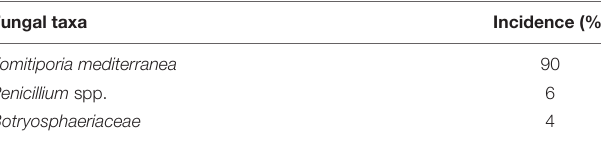
TABLE 3 | Percentage of fungal taxa isolated from wood fragments sampled from grapevine wood tissue adjacent to the tissue area sampled for microscopy. Fungal taxa Incidence (%) Fomitiporia mediterranea 90 Penicillium